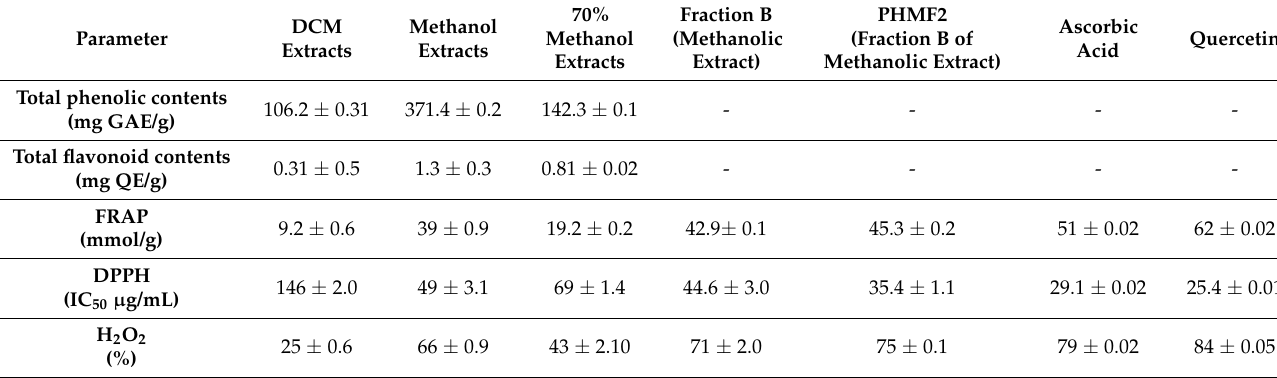
Table 1. Total phenolics and flavonoids content, and antioxidant potential of DCM, MeOH, and 70% MeOH extracts of Peganum harmala crude extracts and subsequent